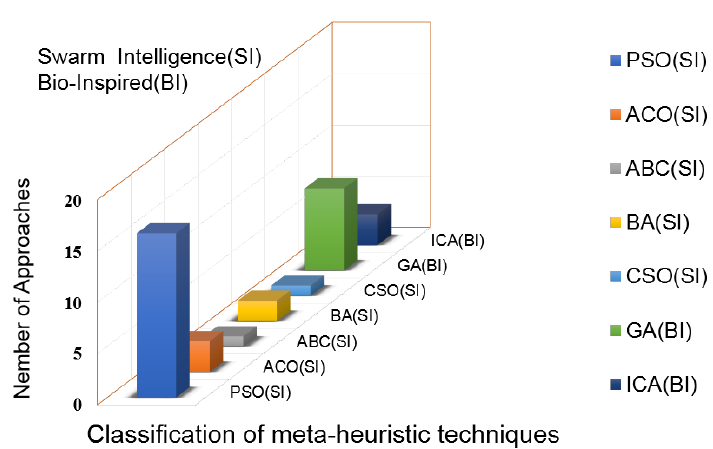
Figure 6. The approaches used for task scheduling in CC